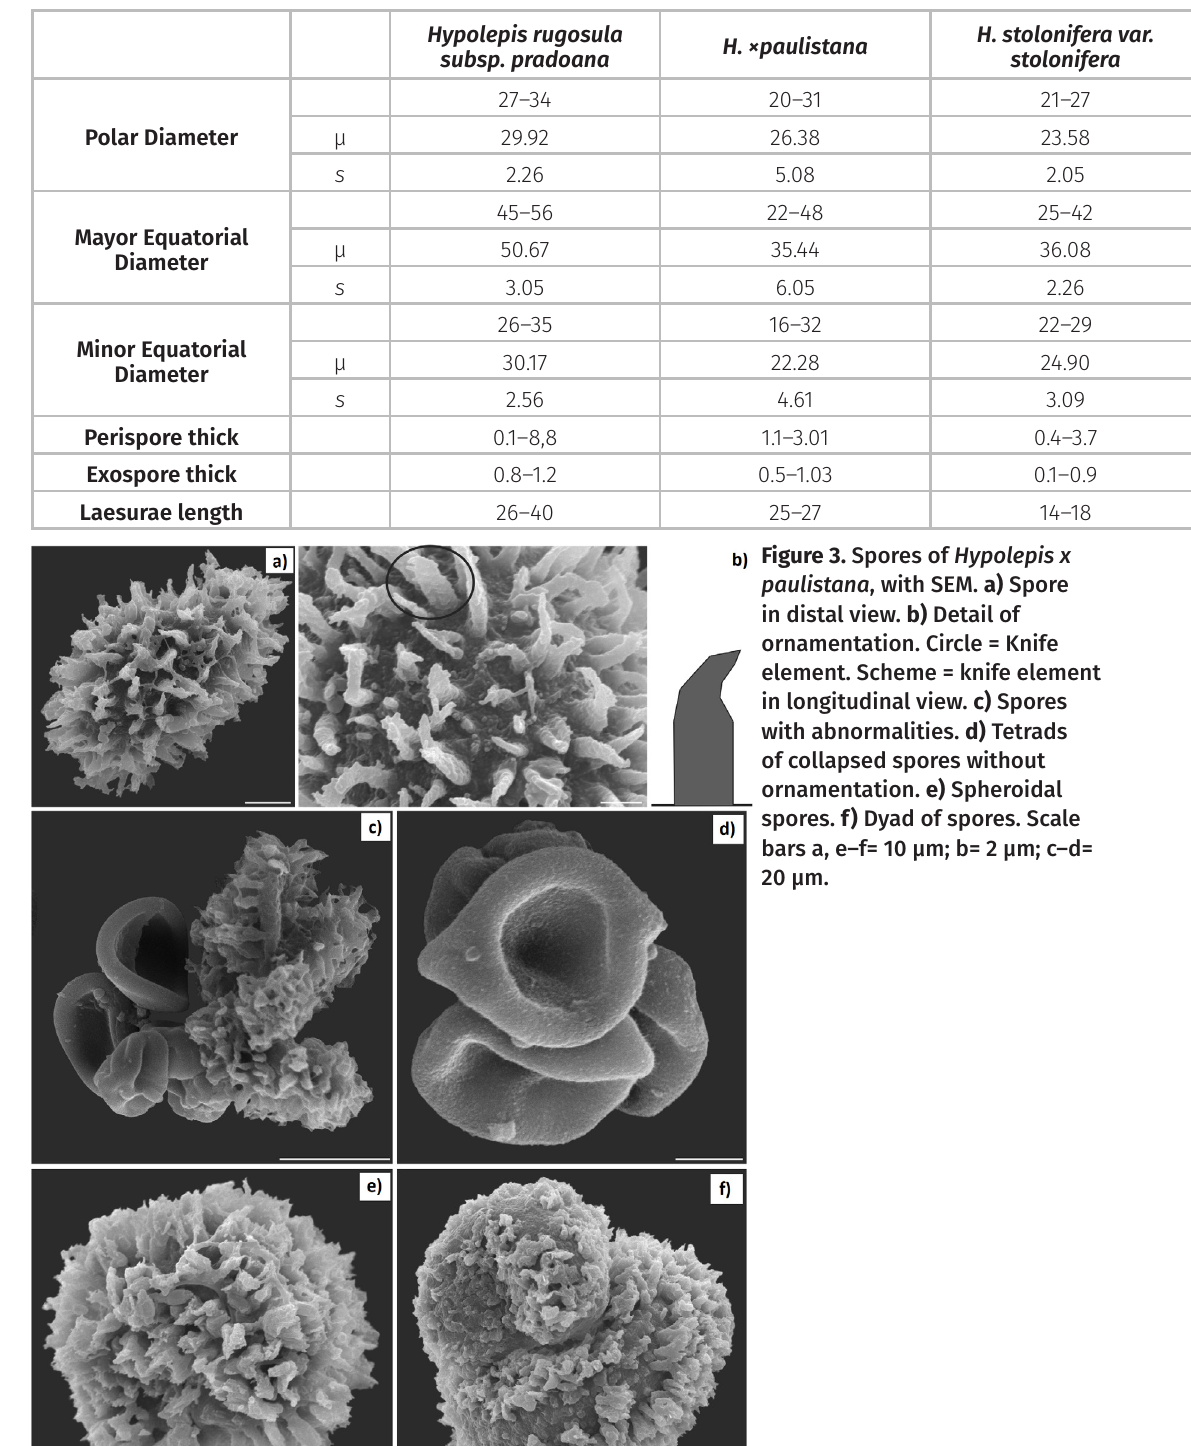
Table II. Spore diameters of H. ×paulistana and potential parent species , Hypolepis rugosula subsp. pradoana and H. stolonifera var. stolonifera . Values expressed in microns. µ = mean, s = standard deviation.